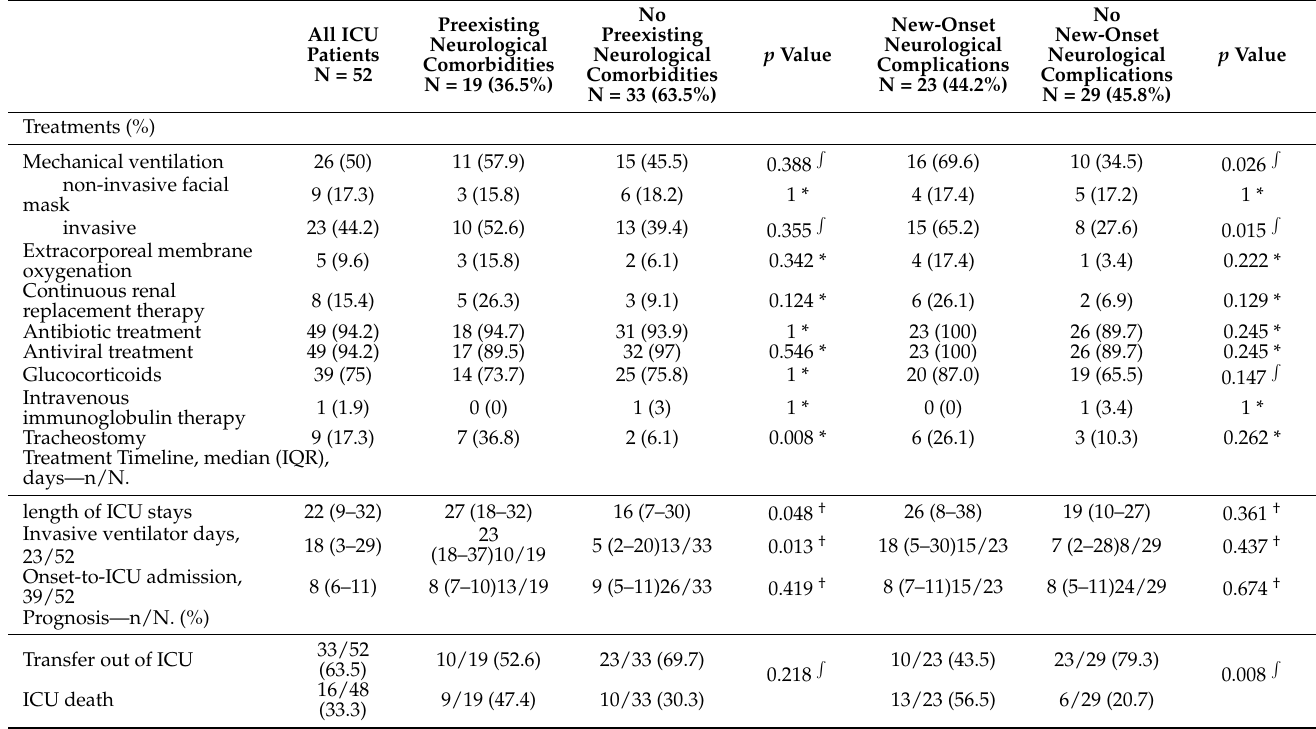
Table 3. Treatment and prognosis of 52 intensive care unit patients infected with COVID-19.